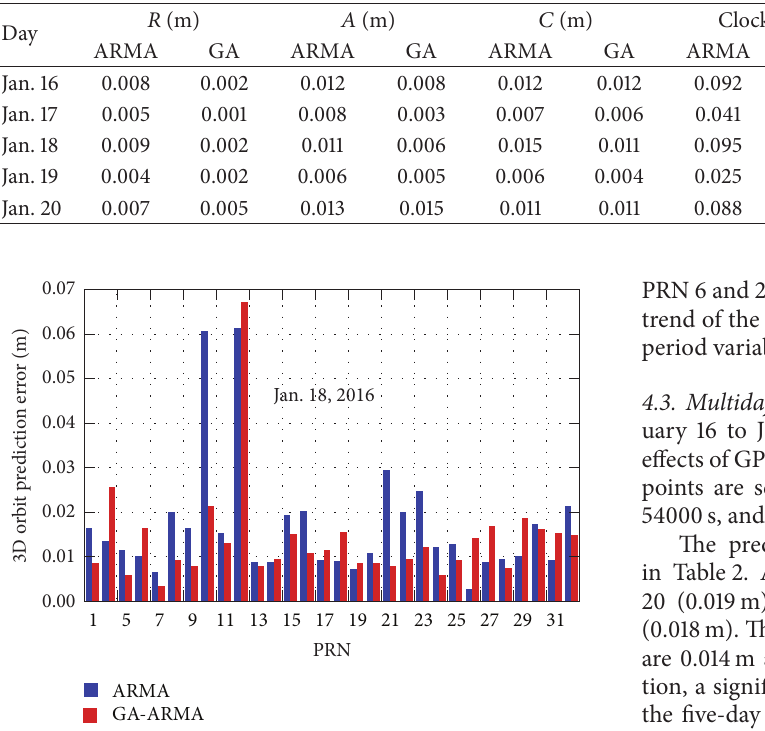
means of the RMS errors are 0.021 m for ARMA and 0.018 m for